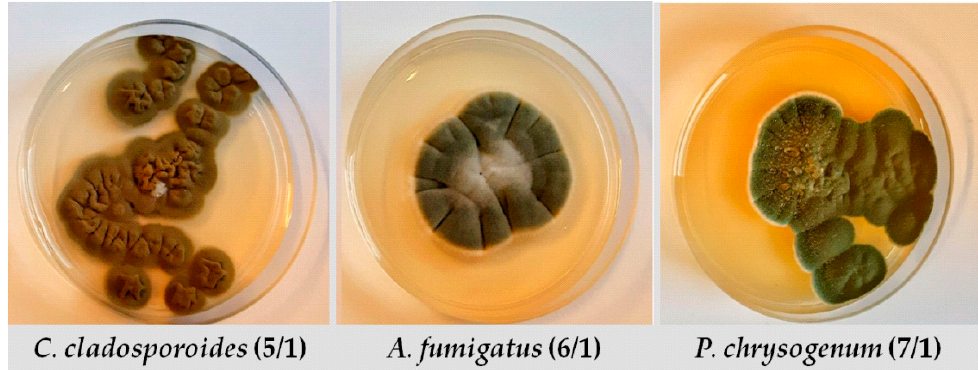
Figure 3. Tested fungal strains.